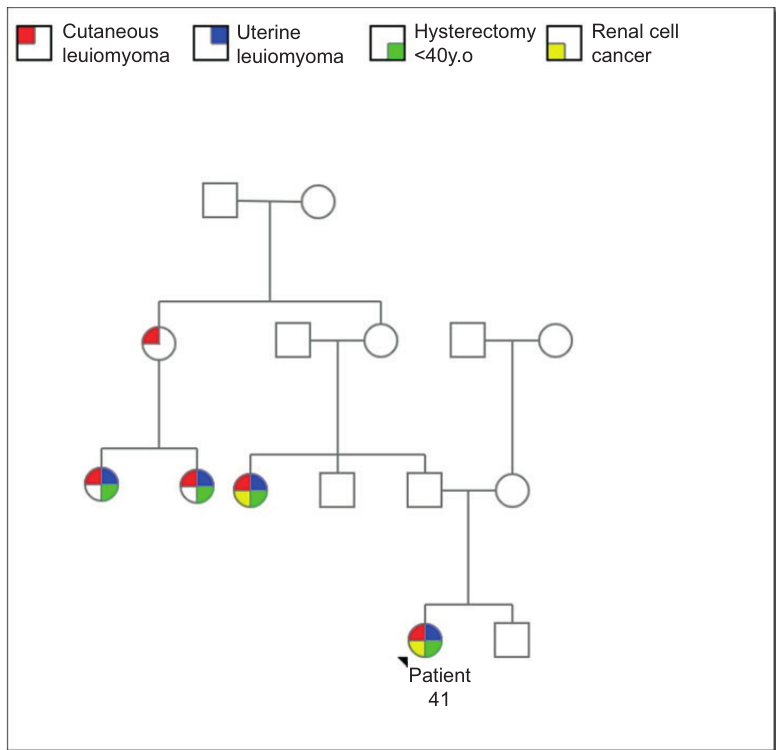
Figure 3: Pedigree of the